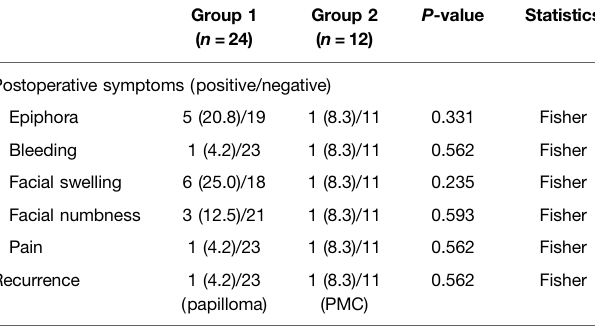
TABLE 3 | Postoperative symptoms and recurrence.